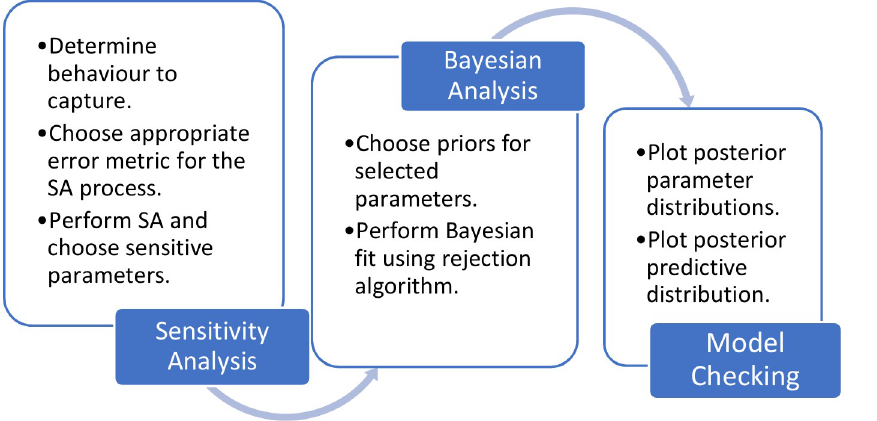
Fig 1. Generalised analysis process. A simplified representation of the Bayesian analysis